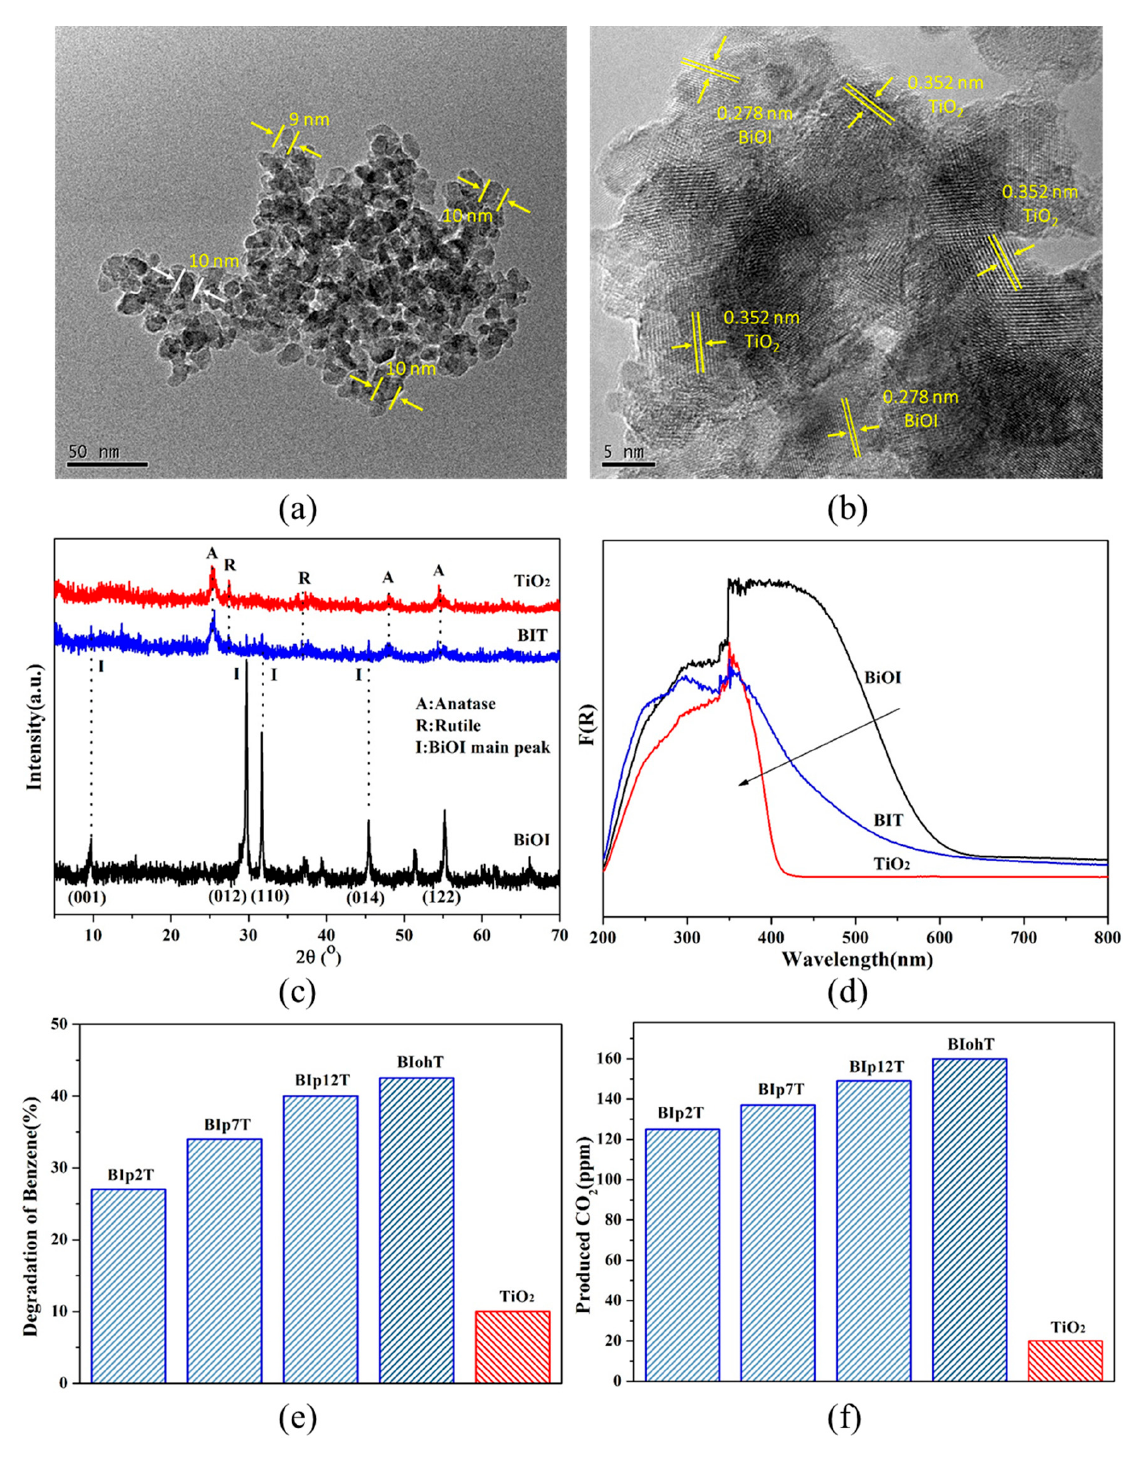
Figure 2. ( a ) TEM images and ( b ) HRTEM images of BIT; ( c ) XRD patterns and ( d ) UV–Vis DRS spectra of BIT, BiOI, and TiO 2 ; ( e ) degradation of benzene; and ( f ) CO 2 produced over BIT and TiO 2.